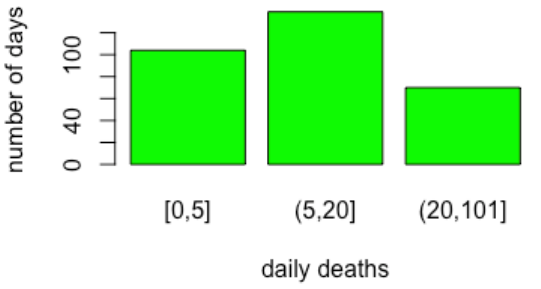
Figure 18. Cut-off points for health variables for Israel.